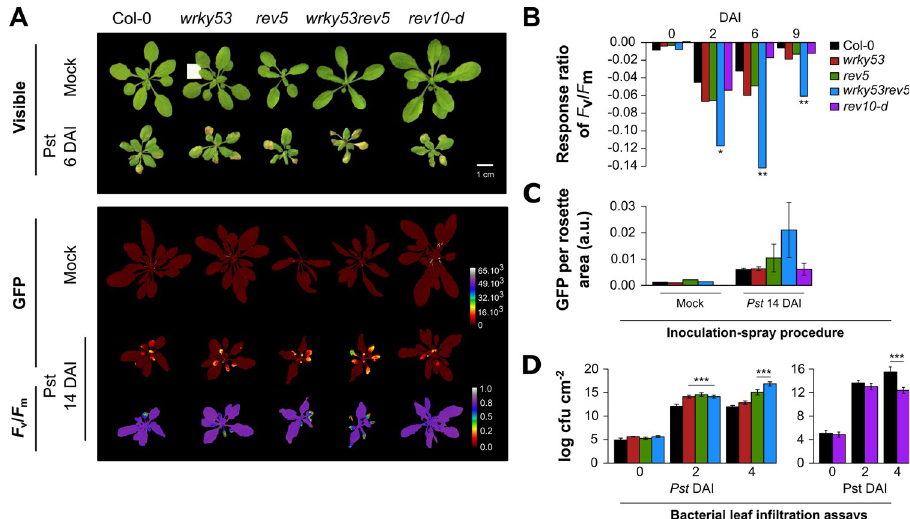
Fig 5. Pathogen assays using Pseudomonas syringae inoculation. 16-day-old plants were infected with Pseudomonas syringae ( Pst ) pv tomato DC3000, constitutively expressing GFP by spraying a Pst suspension on leaf surfaces. Bacterial colonisation was followed by quantification of GFP fluorescence in planta and plant disease was investigated using chlorophyll fluorescence imaging. (A) top : a representative picture of rosettes 6 days after infection (DAI), in parallel to the respective mock condition. Bottom : a representation of GFP fluorencence in planta in mock condition and Pst - infected plants, and photosynthetic efficiency ( F v / F m ) in Pst -infected plants 14 DAI (B) Response ratio of F v / F m during DAI, calculated as the relative ratio of Pst -infected plants compared to mock-treated plants ( Pst -Mock)/Mock. Significant differences were analysed using two-way ANOVA (genotype by treatment interaction) on F v / F m values (n = 6–8; � : P � 0.05 and �� : P � 0.001). (C) Quantification of bacterial growth in planta expressed in GFP units per rosette area compared to the respective mock condition, 14 DAI. Data are means ( ± SE) of 3 plants. (D) Quantification of bacterial growth after infection (cfu = colony forming units). Data are means ( ± SE) of 4–6 plants. Significant differences were analysed using Kruskal–Wallis tests ( ��� : P � 0.001). See also S4